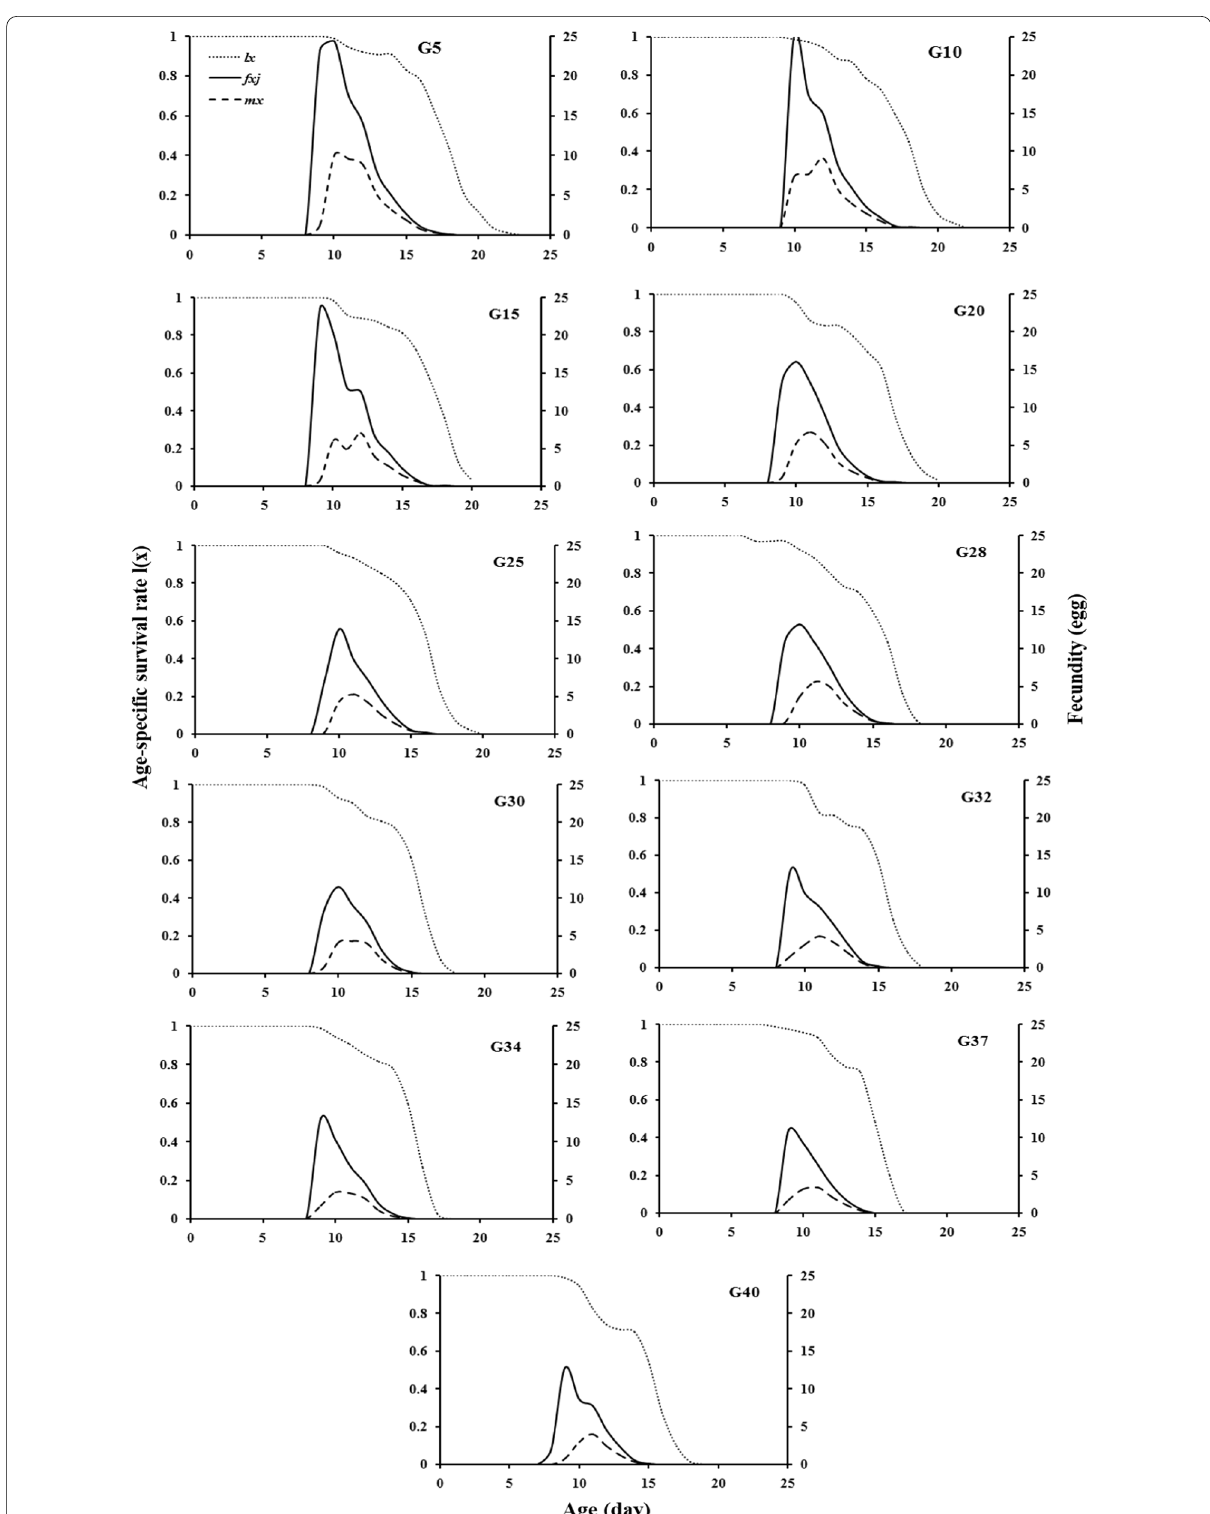
Fig. 3 The age-specific survivorship ( l x ), age-stage-specific fecundity of female ( f xj ) (eggs), and age-specific fecundity ( m x ) of sequential generations of T. embryophagum reared on S. cerealella